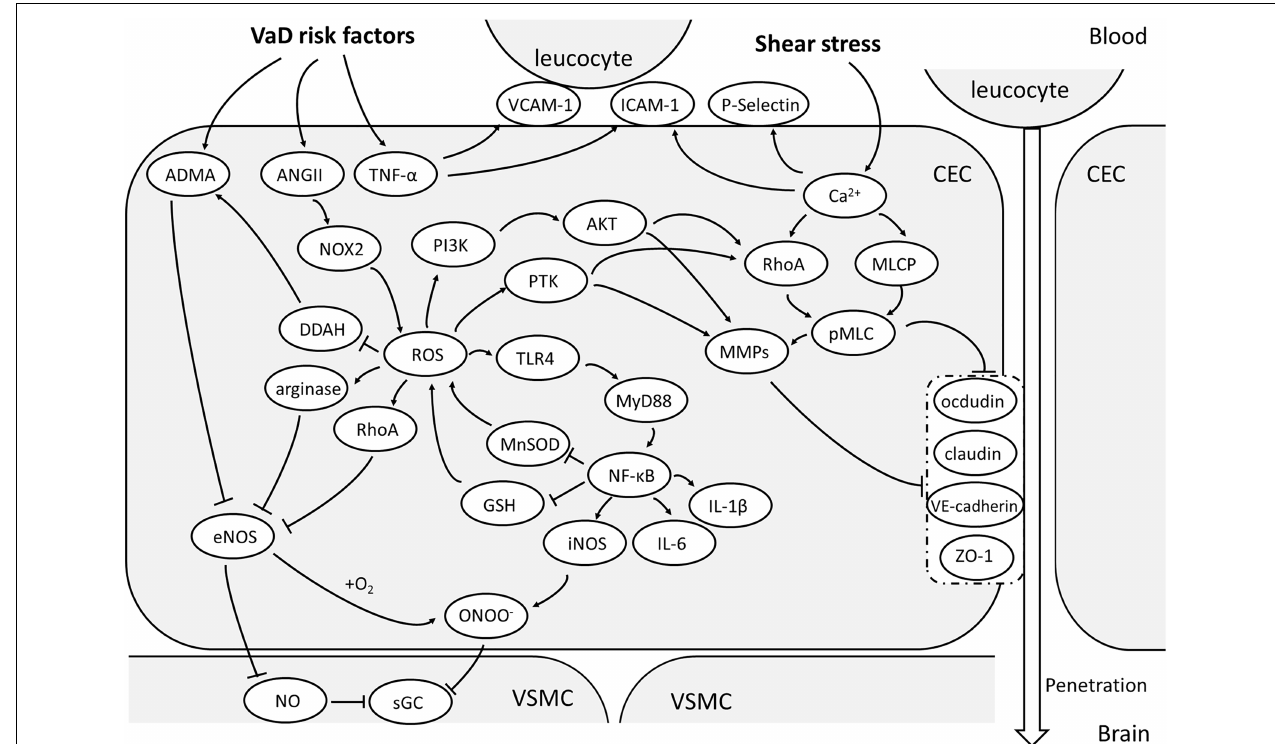
FIGURE 1 | Oxidative stress and activation of CEC. With the vascular risk factors, NOX-2 is the main source of ROS in CECs. With the effect of ROS, ADMA will accumulate and arginase activated, both of which will reduce NO production and increase OONO − via inhibiting eNOS. Together with a large amount of NO due to activation of TLR/MyD88/NF- κ B pathway, OONO − can be produced and attenuate the sensitivity of sGC, making the malfunctioning of VSMC vasodilation. NF- κ B pathway is an important upstream mechanism of the expression of pro-inflammatory factors. ROS could also enhance MMP expression and activate RhoA/pMLC pathway through PTK or PI3K/Akt signaling and consequentially relocate or degrade TJs and AJs, resulting to high paracellular permeability of CECs. The elevated TNF- α promotes the expression of ICAM-1,VCAM-1 and P-selectin, which helps in leucocyte adhesion to CECs and penetration into brain. (AJs, adherent junctions; AMDA, asymmetric dimethylarginine; AKT, protein kinase B; ANGII, angiotensin II; CEC: cerebrovascular endothelial cell; DDAH, dimethylarginine dimethylaminohydrolase; eNOS, endothelial nitric oxide synthase; GSH, glutathione; ICAM-1, intercellular adhesion molecule-1; iNOS, inducible nitric oxide synthase; MLCP, myosin light chain phosphorylatase; MMPs, metalloproteins; MnSOD, manganese-dependent superoxide dismutase; MyD88, myeloid differential protein-88; NF- κ B, nuclear factor- κ B; NO, nitric oxide; NOX-2, nicotinamide adenine dinucleotide phosphate oxidase 2; OONO − , peroxynitrite; PI3K, phosphoinositol 3 kinase; pMLC, phosphorylated myosin light chain; PTK, protein tyrosine kinase; RhoA, Ras homolog gene family member A; ROS, reactive oxygen species; sGC, soluble guanylate cyclase; TJs, tight junctions; TLR4, Toll-like receptor 4; TNF- α , tumor necrosis factor- α ; VCAM-1, vascular cell adhesion molecule-1; VE-cadherin, vascular endothelial cadherin; VSMC, vascular smooth muscle cell; ZO-1, zonula occludens